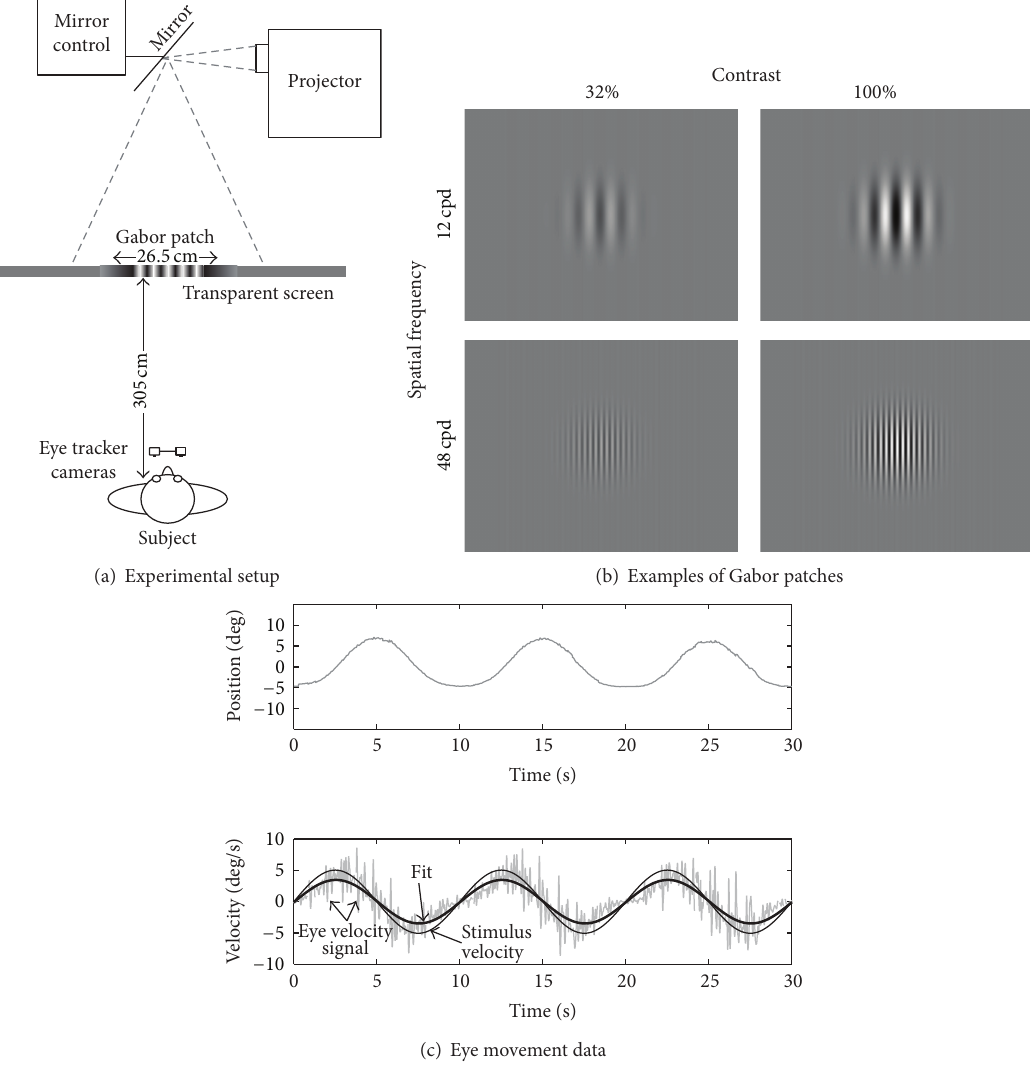
Figure 1: (a) shows a schematic drawing of the experimental setup. The stimulus, a Gabor patch, was back-projected via mirrors on a transparent screen. Movement of the mirrors induced a horizontal movement on the screen. (b) shows four examples of Gabor patches. Each stimulus contained a Gabor patch with a unique combination of spatial frequency and black-white contrast. (c) shows an example of the eye movements of an observer who explicitly followed the movement of the Gabor patch. This observer was not included in this experiment. The Gabor patch moved sinusoidally from left to right in the horizontal plane. The top plot of (c) shows the raw eye position trace. The bottom plot of (c) shows the corresponding eye velocity trace (gray line), the stimulus velocity trace (thin black line), and the fitted sinusoid through the eye velocity signal (thick black